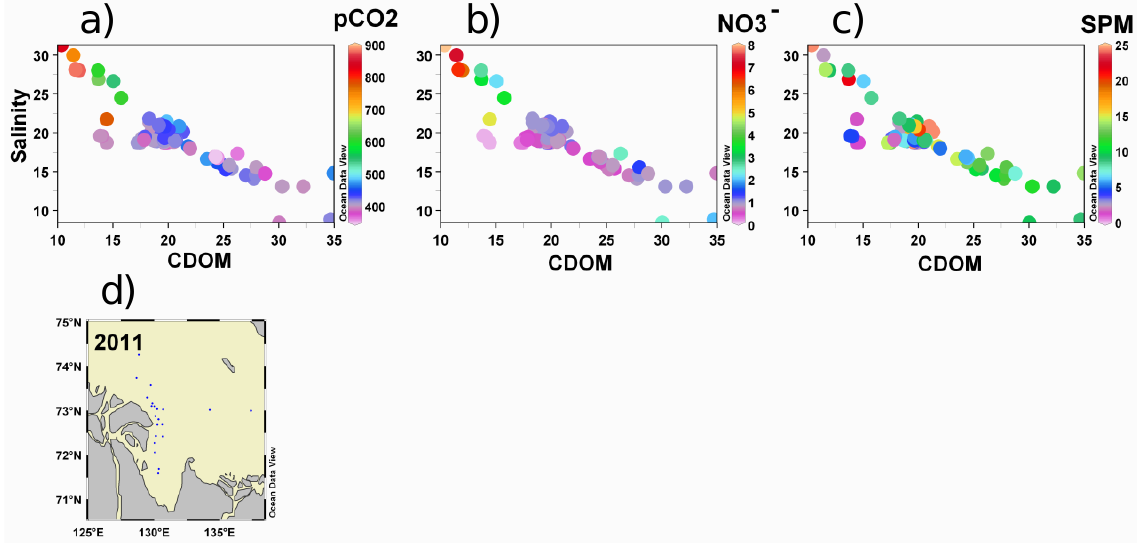
, µM) color-coded by 3